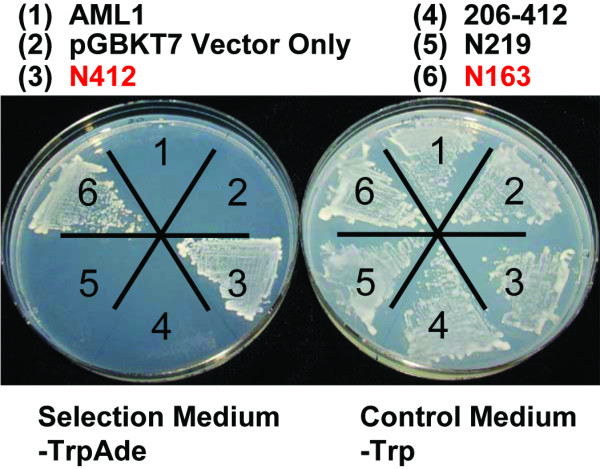
The AML1 N-terminus harbors transcriptional activation domain activity. One-hybrid assay on AML1 fragments cloned into pGBK. The plate at left lacks tryptophan and adenine, and growth indicates transcriptional activation domain activity in the tested fragments. The control plate at right lacks adenine, and indicates transformation of the cells with the desired pGBK construct.